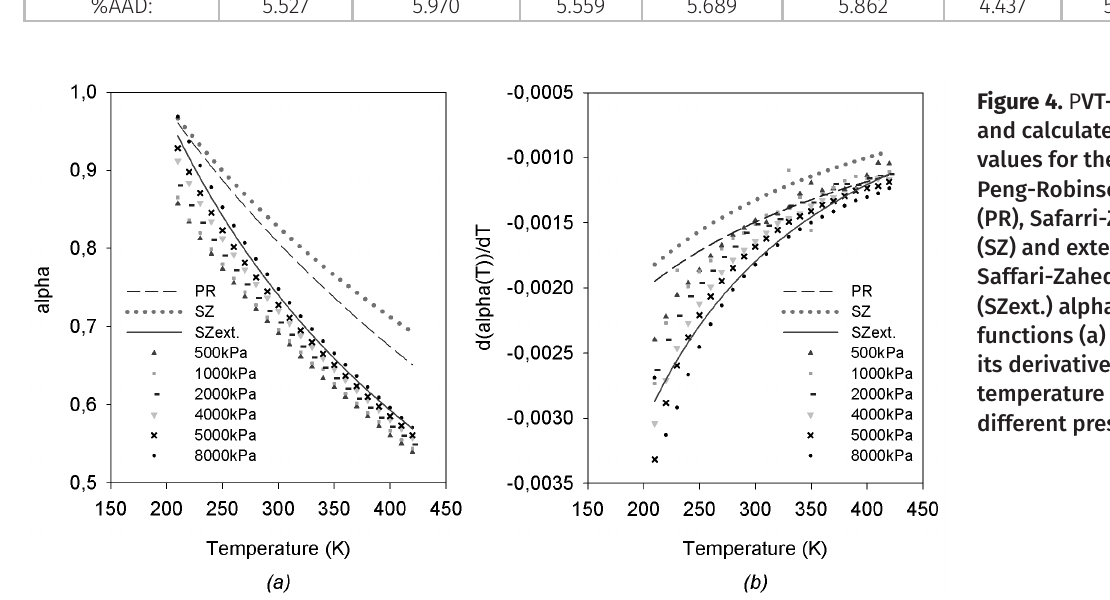
Equation of state/Alpha function PR- PR- PR-Mathias- Gasem original Copeman (%AD) (%AD) (%AD)